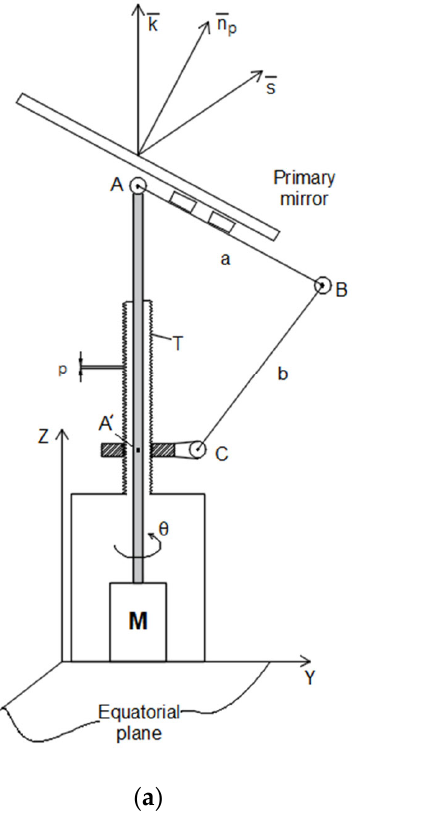
Figure 2. ( a ) Schematic diagram of the mechanical operating principle for the proposed heliostat. ( b ) Significant measures for the proposed heliostat.